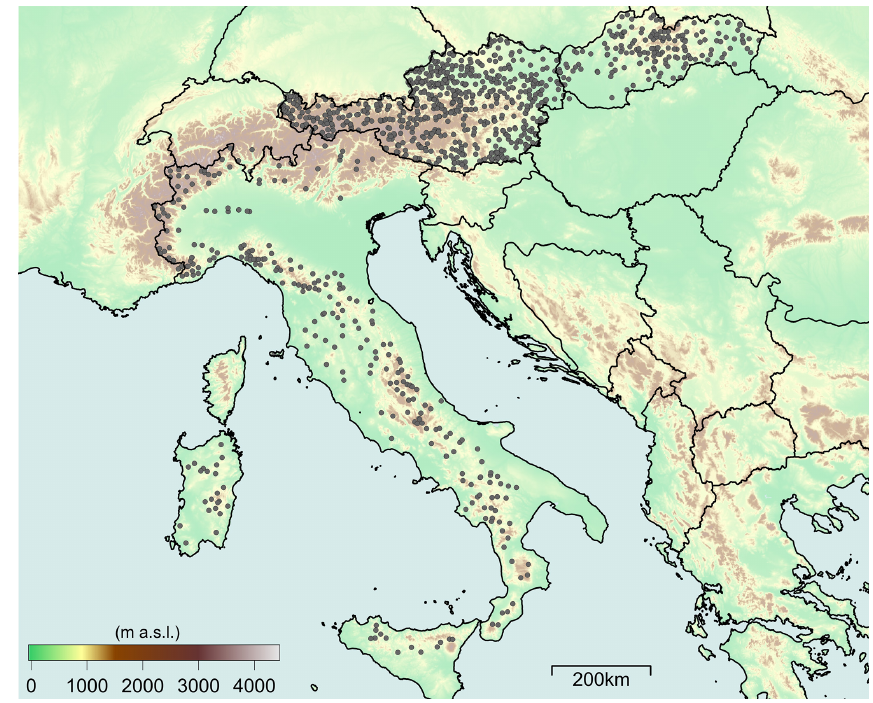
Figure 1. Map showing the location of the 1132 considered Austrian, Italian and Slovakian gauging stations (points). Colour scale in the background represents terrain elevation in metres a.s.l. (above sea level).